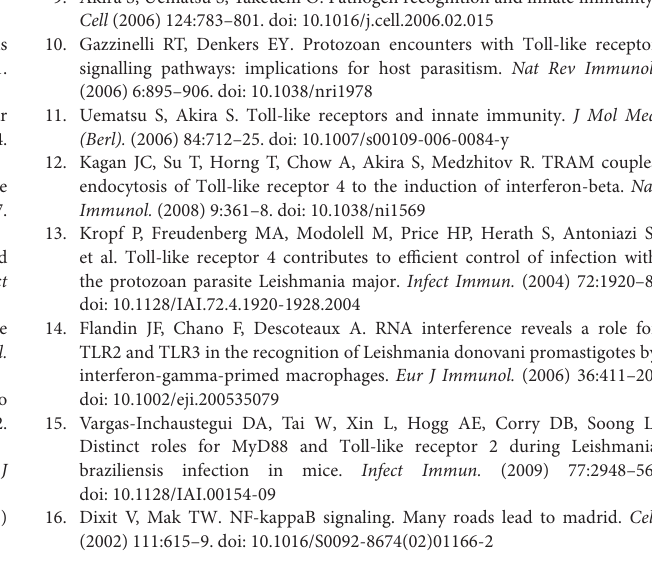
or − 1.2 of Fold Regulation, respectively. Only significant ( p < 0.05) Fold Regulation values are presented. Figure S2 | Inhibition of let-7 functions. BMDMs were transiently transfected with 100nM negative control (NC) or let-7e-5p inhibitor. Twenty-four hours after transfection incubation, cells were co-cultivated with L. amazonensis (MOI 5:1) for 4h, and the cultures were then washed. After 4 and 24h of infection, the samples were analyzed for let-7e levels normalized to SNORD95 (A) , and levels of the Cat2B (B) , and Cat1 (C) mRNAs using RT-qPCR. The values were normalized to the average values of NC-transfected, infected macrophages (100%). Each bar represents the average ± SEM of the values obtained from three independent experiments ( n = 3–6). Statistical significance was determined using two-tailed Student’s t -tests. ∗ p < 0.05 compared to negative control-transfected, infected macrophages. Figure S3 | Expression of mRNAs encoding proteins in the TLR pathway molecules and cytokines in L. amazonensis -infected macrophages. The BMDMs (5 × 10 6 ) from WT mice were infected with L. amazonensis (MOI 5:1). Each dot represents one mRNA in BMDMs from WT mice infected with L. amazonensis for 4 and 24h. Blue dots indicate upregulated mRNAs and orange dots indicate downregulated mRNAs. The blue dotted line corresponds to p = 0.05, log 10. The relative up- and downregulation of miRNAs are presented as boundaries of 1.2 or − 1.2 of Fold Regulation, respectively. P -values were determined using two-tailed Student’s t -test. Representative data from three independent experiments are shown. Table S1 | C57BL/6 (WT), MyD88 − / − , TLR2 − / − , and TLR4 − / − murine macrophages during L. amazonensis infection. FR (Fold Regulation) represents the fold change results at a biological magnitude. Values > 1.2 indicate positive regulation and values < -1.2 indicate negative regulation. Table S2 | Predicted target mRNAs of the let-7e miRNA. The miRNA-mRNA interactions predicted using miRecord tools (http://c1.accurascience.com/ miRecords/) were based on the integration of the predicted targets obtained from at least three of the following prediction tools: DIANA-microT, MicroInspector, miRanda, MirTarget2, miTarget, NBmiRTar, PicTar, PITA, RNA22, RNAhybrid, and TargetScan/TargertScanS. Table S3 | Let-7e inhibition alters the levels of mRNAs in the TLR pathway in WT macrophages during L. amazonensis infection. FR (Fold Regulation) represents the fold change results at a biological magnitude. Values > 1.2 indicates positive regulation and values < -1.2 indicate negative